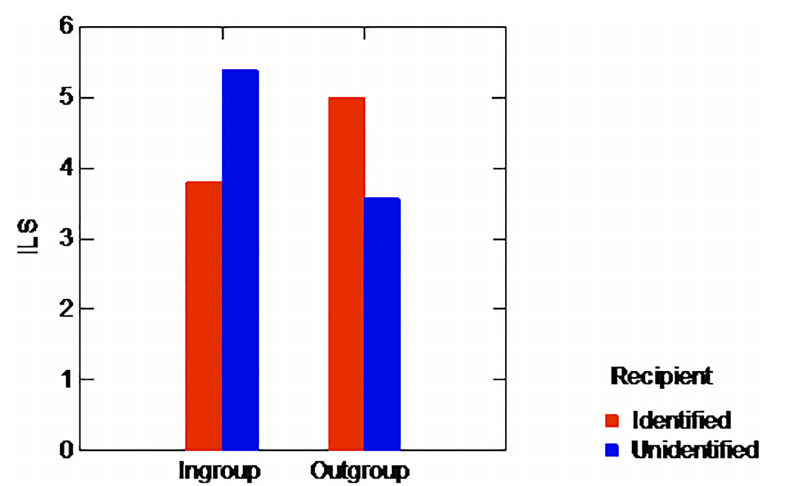
Fig 2. Mean allocation by recipient’s group affiliation and identifiability, Experiment